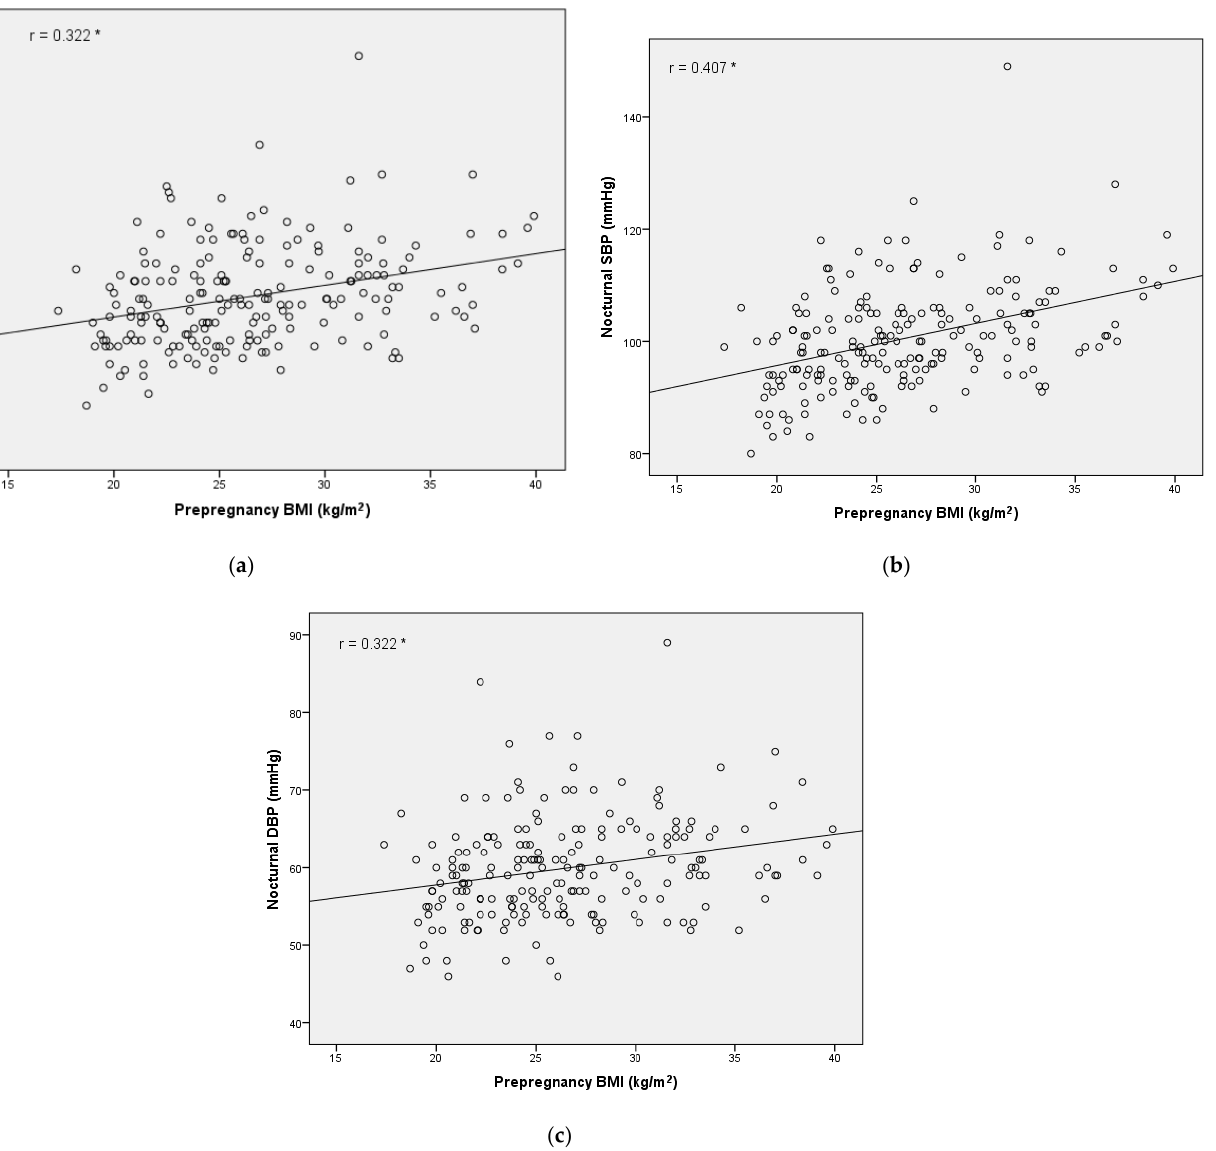
Figure 2. ( a ) Correlation between 24 h SBP and prepregnancy BMI. ( b ) Correlation between nocturnal SBP and prepregnancy BMI. ( c ) Correlation between nocturnal DBP and prepregnancy BMI. Linear correlation between ABPM parameters and prepregnancy BMI. Correlations were evaluated using Spearman’s correlation test r. * p < 0.01. ABPM: ambulatory blood pressure monitoring; SBP: systolic blood pressure; DBP: diastolic blood pressure; and BMI: body mass index. Table 2. Characteristics of pregnancy and obstetric and perinatal outcomes according to the pres- ence of GDM and/or obesity.